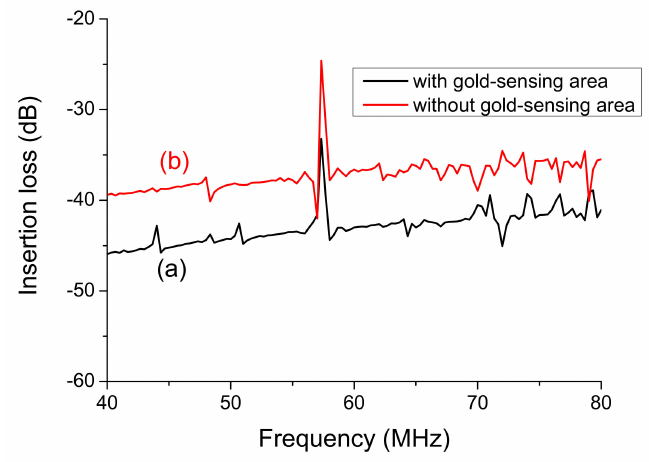
Figure 5. The frequency response of SAW sensors ( a ) with and ( b ) without the deposition of gold-sensing area on top of the SiO 2 guiding layer.